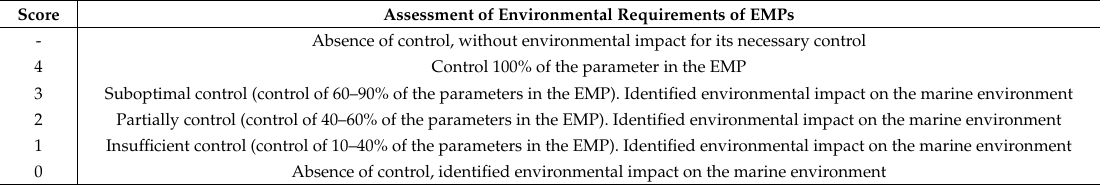
Table 2. Semiquantitative scale used for evaluating the environmental requirements of environmental monitoring plans